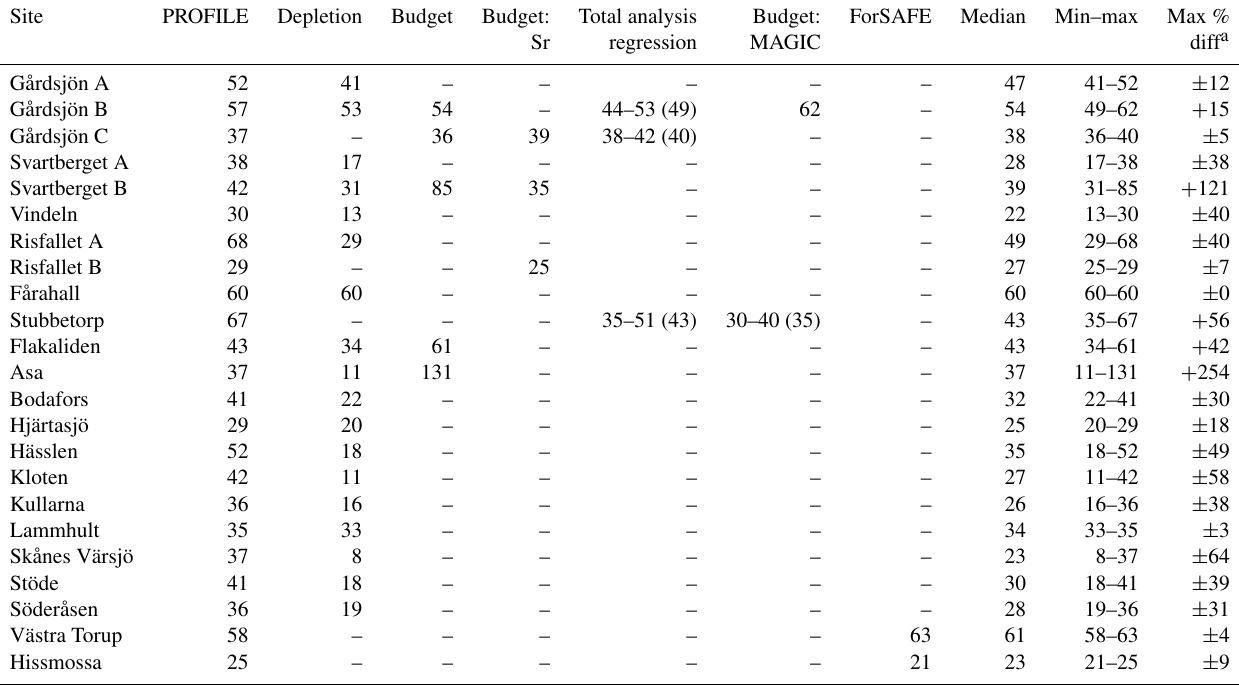
Table 3. Weathering rates (meqm − 2 yr − 1 ) and statistics at the sites described in Table 1. Values in parentheses after the intervals represent the middle of the